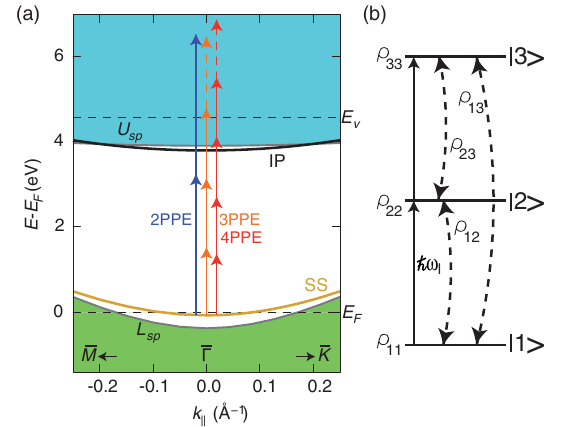
FIG. 1. (a) Surface projected band structure of Ag(111) after Ref. [80]. The lower ( L sp ) and the upper ( U sp ) bulk sp bands are shown by green and light blue shading bracketing the projected band gap, respectively. The Shockley surface state, which is occupied for a narrow k k range, is plotted in ocher and the first image potential state in black. Photoemission of electrons from the SS state is induced in second-, third-, and fourth-order mPP ( m ¼ 2 , 3, 4) processes, depending on the photon energy, as indicated by the arrows. ATP in m ¼ ð 3 þ 1 Þ - and m ¼ ð 4 þ 1 Þ - photon excitation is indicated by the dashed arrows. (b) Diagram of a canonical three-level system used in OBE simulations consisting of the occupied initial state j 1 i , the unoccupied intermediate j 2 i , and the final photoelectron state j 3 i . Upward and dashed arrows indicate population transfers and coherences between the levels, respectively, which are labeled with the corresponding elements of the density matrix ˆ ρ ; the state energies depend on a specific electronic